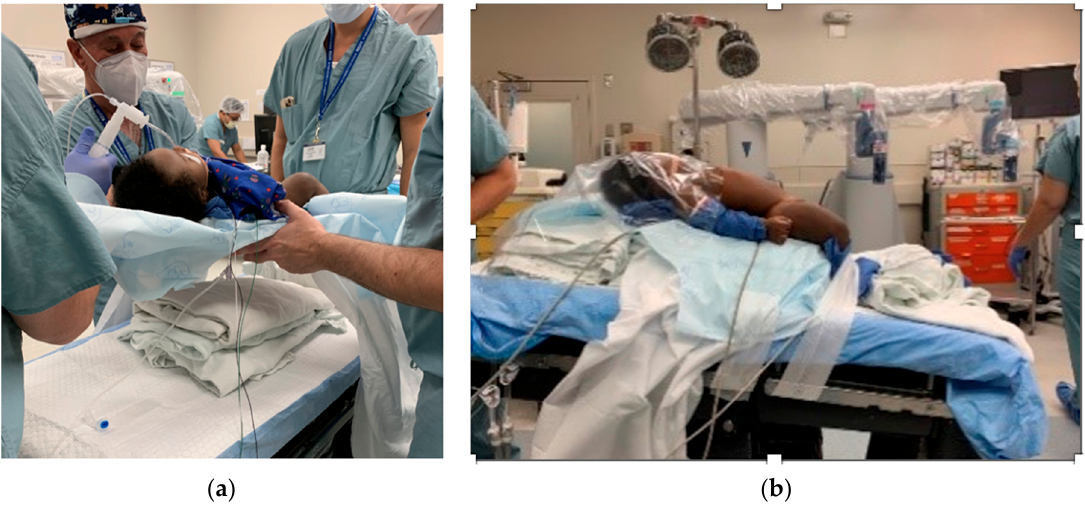
Figure 1. Elevation of infants permits better lateral movements of the instruments. a) Elevation using folded surgical sheets. b) Position of the infant on the operating table. using folded surgical sheets. ( b ) Position of the infant on the operating table.